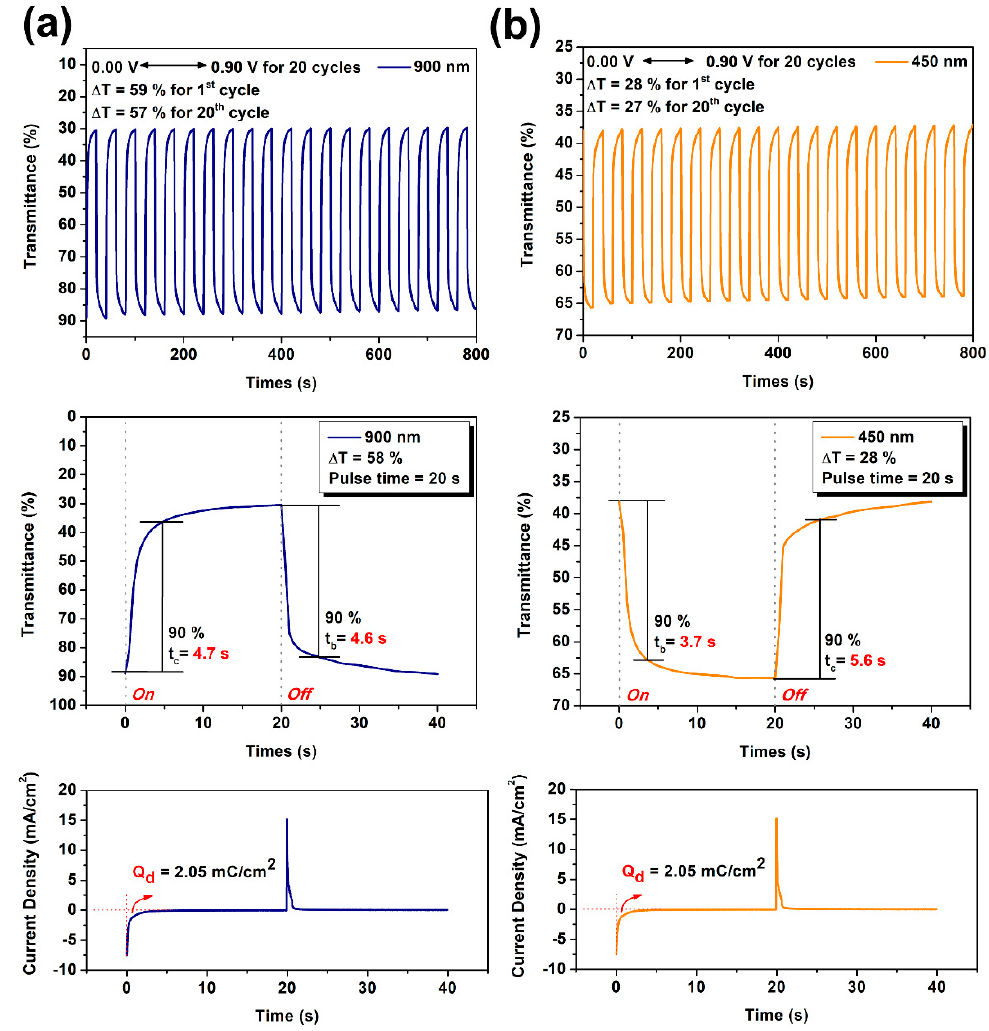
Figure 12. Potential step absorptiometry of the P2 film (from DPPA-2SNS) on the ITO-glass slide (in MeCN with 0.1 M Bu 4 NClO 4 as a supporting electrolyte) by applying a potential step: ( a ) 0.00 V ↹ 0.90 V (20 cycles) with a pulse width of 20 s at λ max = 900 nm and ( b ) 0.00 V ↹ 0.90 V (20 cycles) with a pulse width of 20 s at λ max = 450 nm. The optical contrast and response times were calculated for the first switching cycle.